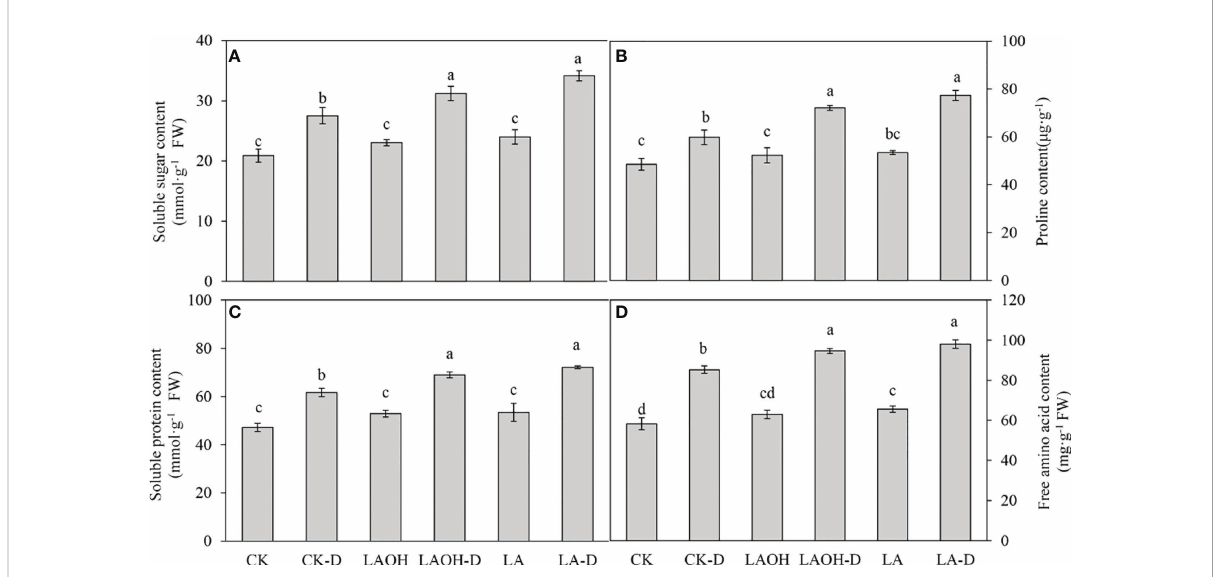
FIGURE 6 Effects of LA-OH and LA on osmoregulatory substances in P. persica under drought stress (A) soluble sugar content; (B) proline content; (C) soluble protein content; (D) free amino acid content). Data are mean ± SD (n = 3). Duncan ’ s test and ANOVA were used. Signi fi cant differences (P < 0.05) are indicated by different